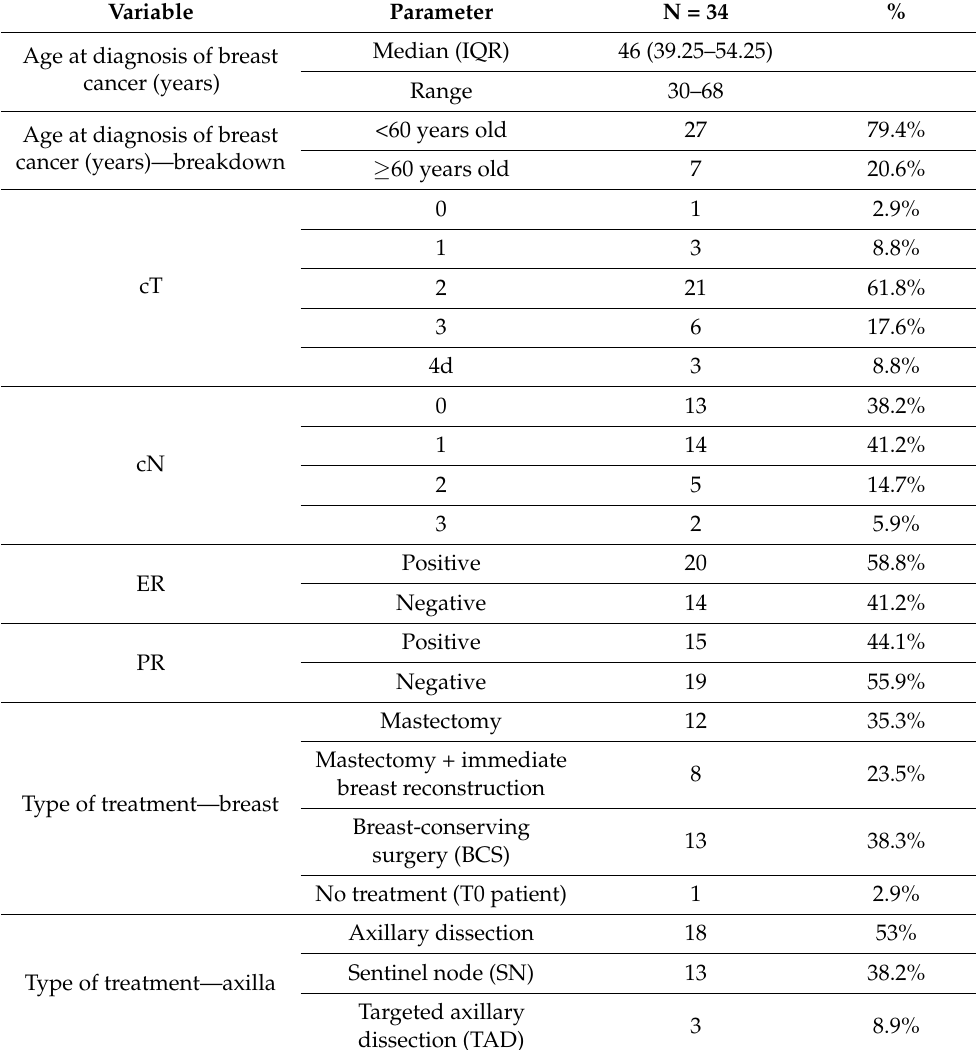
Table 1. Patient